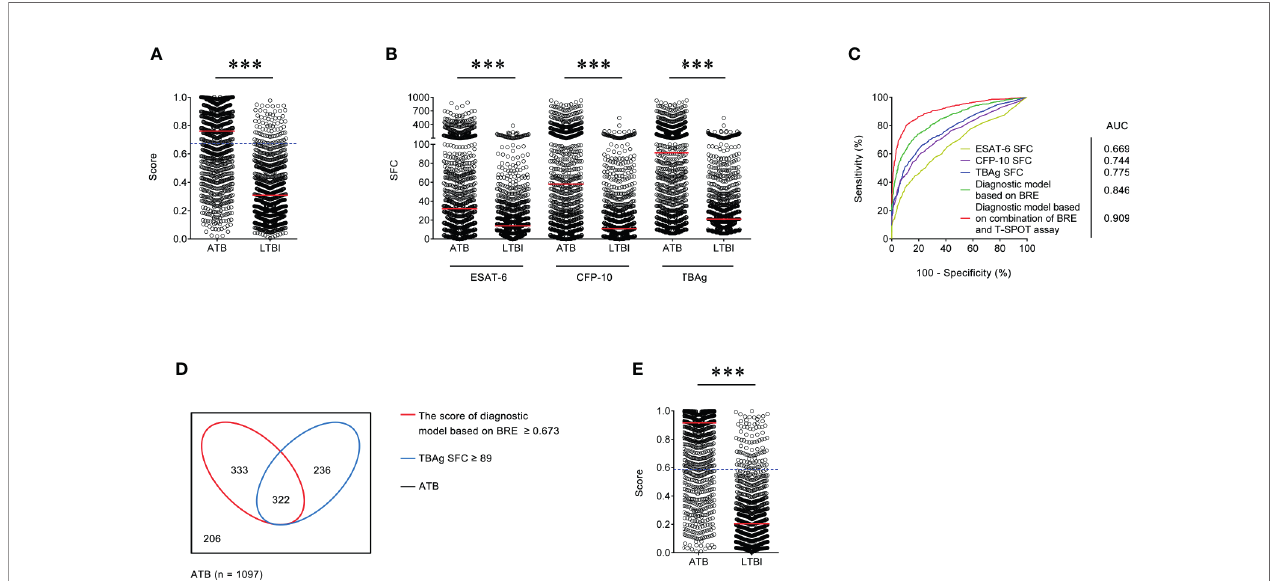
FIGURE 1 | Establishment of diagnostic model based on combination of BRE and T-SPOT in Qiaokou cohort. (A) Scatter plots showing the score of diagnostic model based on BRE in ATB patients (n = 1,097) and LTBI individuals (n = 962) in Qiaokou cohort. Horizontal lines indicate the median. *** P < 0.001 (Mann-Whitney U test). Blue dotted lines indicate the cutoff value in distinguishing these two groups. (B) Scatter plots showing ESAT-6 SFC, CFP-10 SFC, and TBAg SFC in ATB patients (n = 1,097) and LTBI individuals (n = 962) in Qiaokou cohort. Horizontal lines indicate the median. *** P < 0.001 (Mann-Whitney U test). (C) ROC analysis showing the performance of ESAT-6 SFC, CFP-10 SFC, TBAg SFC, diagnostic model based on BRE, diagnostic based on combination of BRE and T-SPOT in distinguishing ATB from LTBI in Qiaokou cohort. (D) Venn diagrams showing the overlap of the diagnostic model based on BRE and TBAg SFC in ATB patients (n = 1,097) in Qiaokou cohort. (E) Scatter plots showing the score of diagnostic model based on combination of BRE and T-SPOT in ATB patients (n = 1,097) and LTBI individuals (n = 962) in Qiaokou cohort. Horizontal lines indicate the median. *** P < 0.001 (Mann-Whitney U test). Blue dotted lines indicate the cutoff values in distinguishing these two groups. ATB, active tuberculosis; LTBI, latent tuberculosis infection; ESAT-6, early secreted antigenic target 6; CFP-10, culture fi ltrate protein 10; TBAg, tuberculosis-speci fi c antigens; SFC, spot-forming cells; AUC, area under the curve; BRE, blood routine